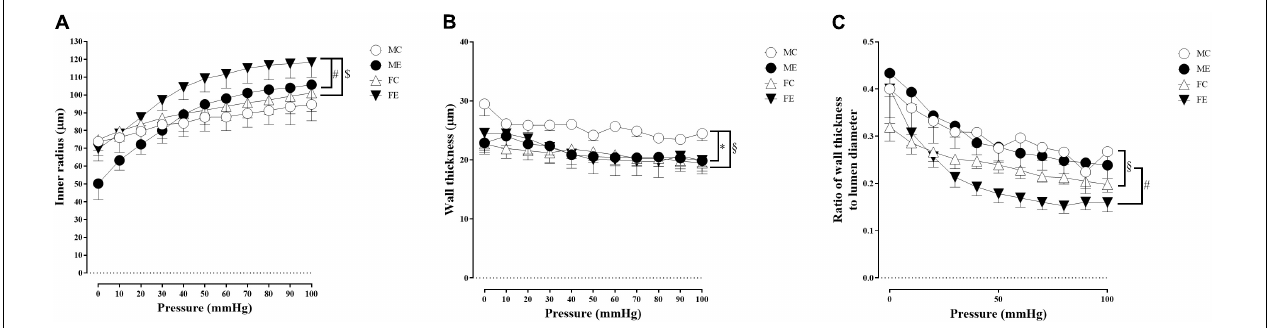
FIGURE 1 | Morphological parameters of arteries from the gracilis muscle. (A) Inner radius of the gracilis muscle arterioles from the MC, ME, FC, and FE animals. The values of the inner radius as a function of intraluminal pressure measured under passive conditions (in calcium-free Krebs solution). The inner radius was increased in female exercised rats compared to FC and ME animals. Data are expressed as the mean (SEM) values. The significance levels of two-way ANOVA and Tukey’s post hoc tests between the four groups are shown. $ P < 0.05 FC vs. FE; # P < 0.05 ME vs. FE. (B) Wall thickness of the gracilis muscle arterioles from MC, ME, FC, and FE animals. The values of the wall thickness as a function of intraluminal pressure measured under passive conditions (in calcium-free Krebs solution). The wall thickness was decreased in the ME group compared to the MC group, and this value was higher in MC rats than in FC animals. Data are expressed as the mean (SEM) values. The significance levels of two-way ANOVA and Tukey’s post hoc tests between the four groups are shown. ∗ P < 0.05 MC vs. ME; § P < 0.05 MC vs. FC. (C) Wall thickness to lumen diameter ratio of the gracilis muscle arterioles from MC, ME, FC, and FE animals. The wall thickness to lumen ratio was significantly smaller in FC and FE rats than MC and ME rats. Data are expressed as the mean (SEM) values. The significance levels of two-way ANOVA and Tukey’s post hoc tests between the four groups are shown. § P < 0.05 MC vs. FC; # P < 0.05 ME vs. FE.